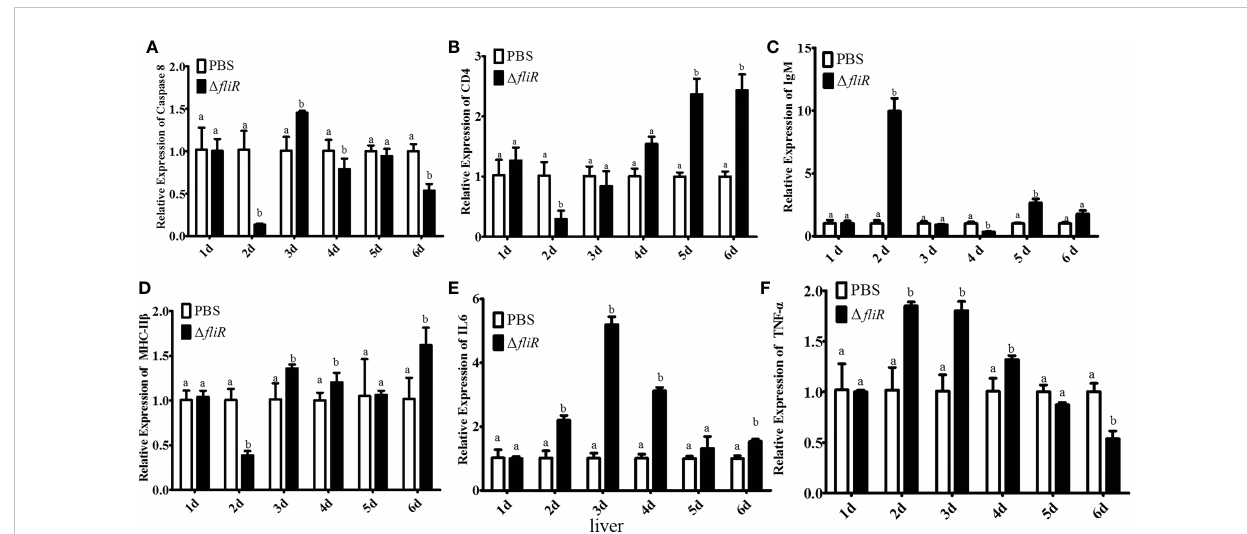
FIGURE 8 The expression levels of immune-related genes in grouper liver after immunization were detected by qRT-PCR for (A) Caspase8 , (B) CD4 , (C) IgM , (D) MHC-II b , (E) IL6 , (F) TNF- a . Groups with notable differences are labeled with different letters above the bars. b -actin was chosen as the reference gene. Data are shown as mean ± SEM (n = 3).